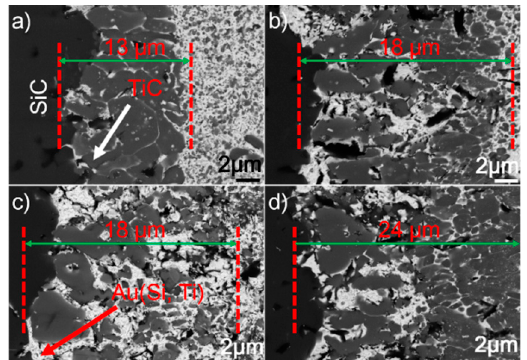
Figure 9. BSE images indicating the reaction layer at the SiC/braze interface obtained at 1523 K for different soaking times: ( a ) 10 min; ( b ) 30 min; ( c ) 60 min; ( d ) 90 min.